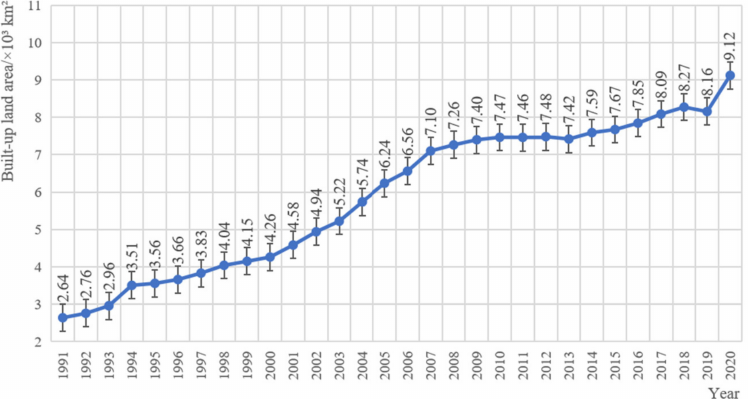
Figure 13. Built-up land area and its standard error statistics in annual classification